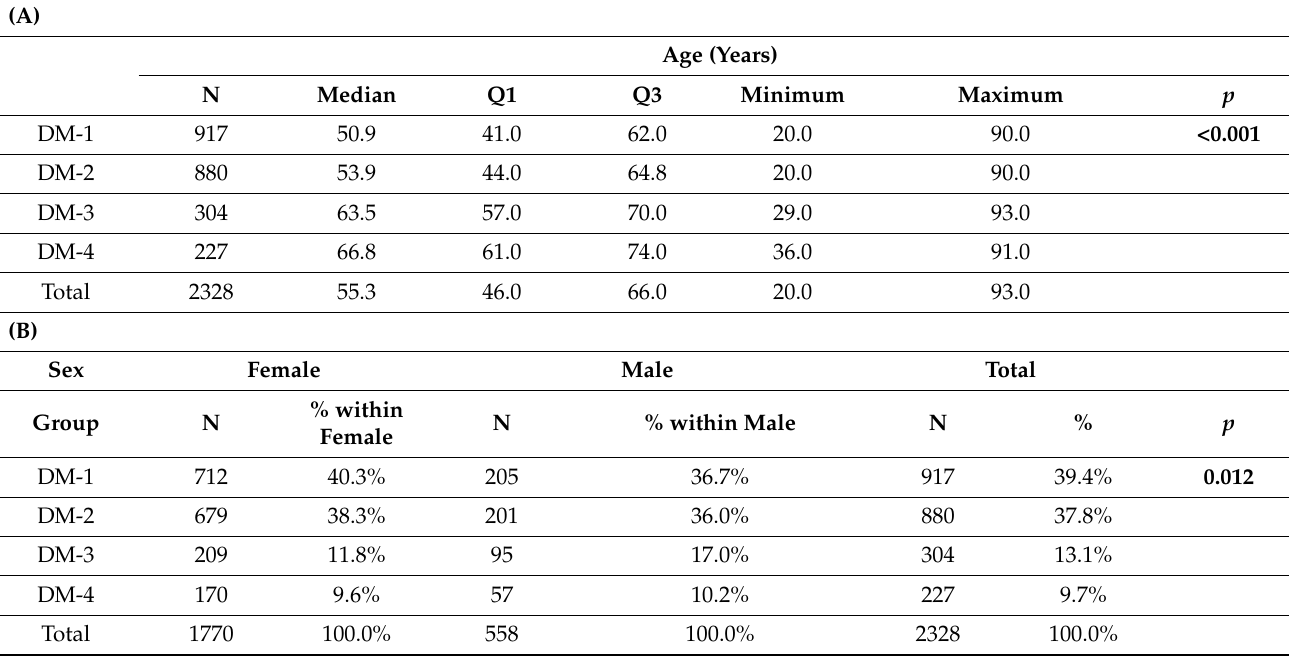
Table 1. Summary of patients’ demographic characteristics. (A) Summary of patient age. (B) Distribution of dermatochalasis in females and